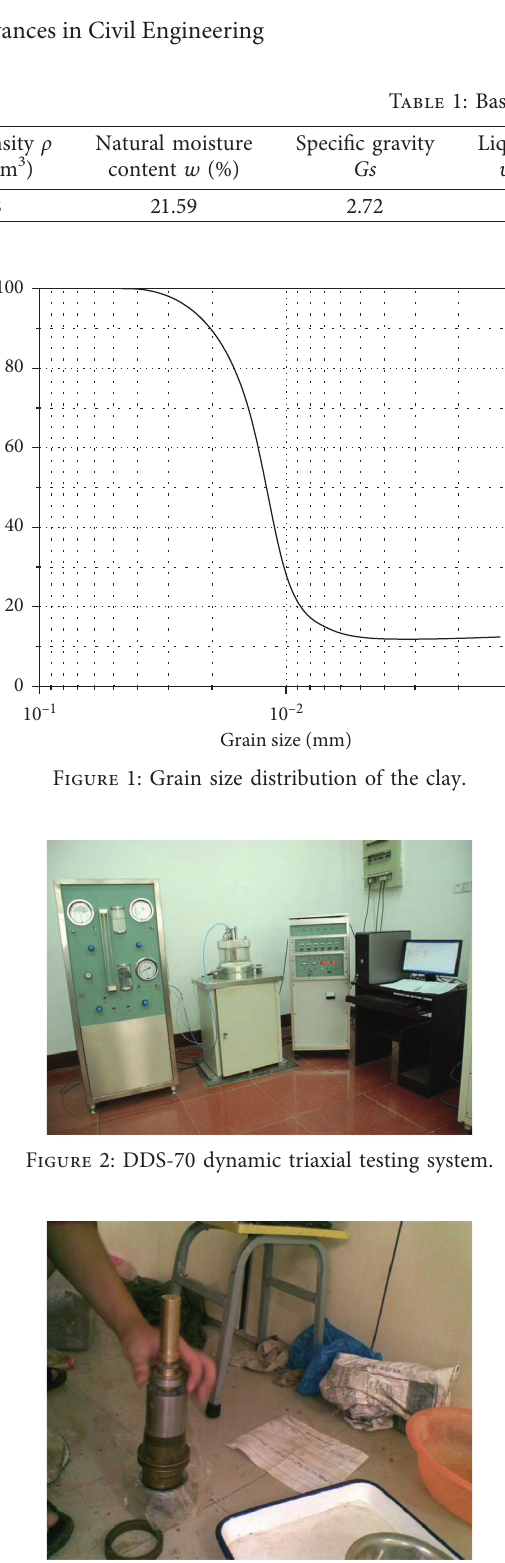
Figure 3: Sample compaction.